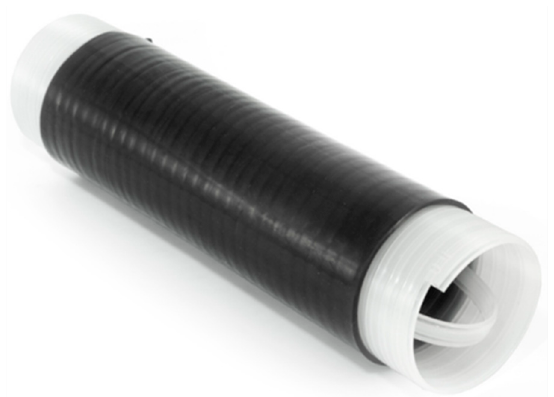
Figure 2. An example of a cold-shrinkable cable joint before its installation.